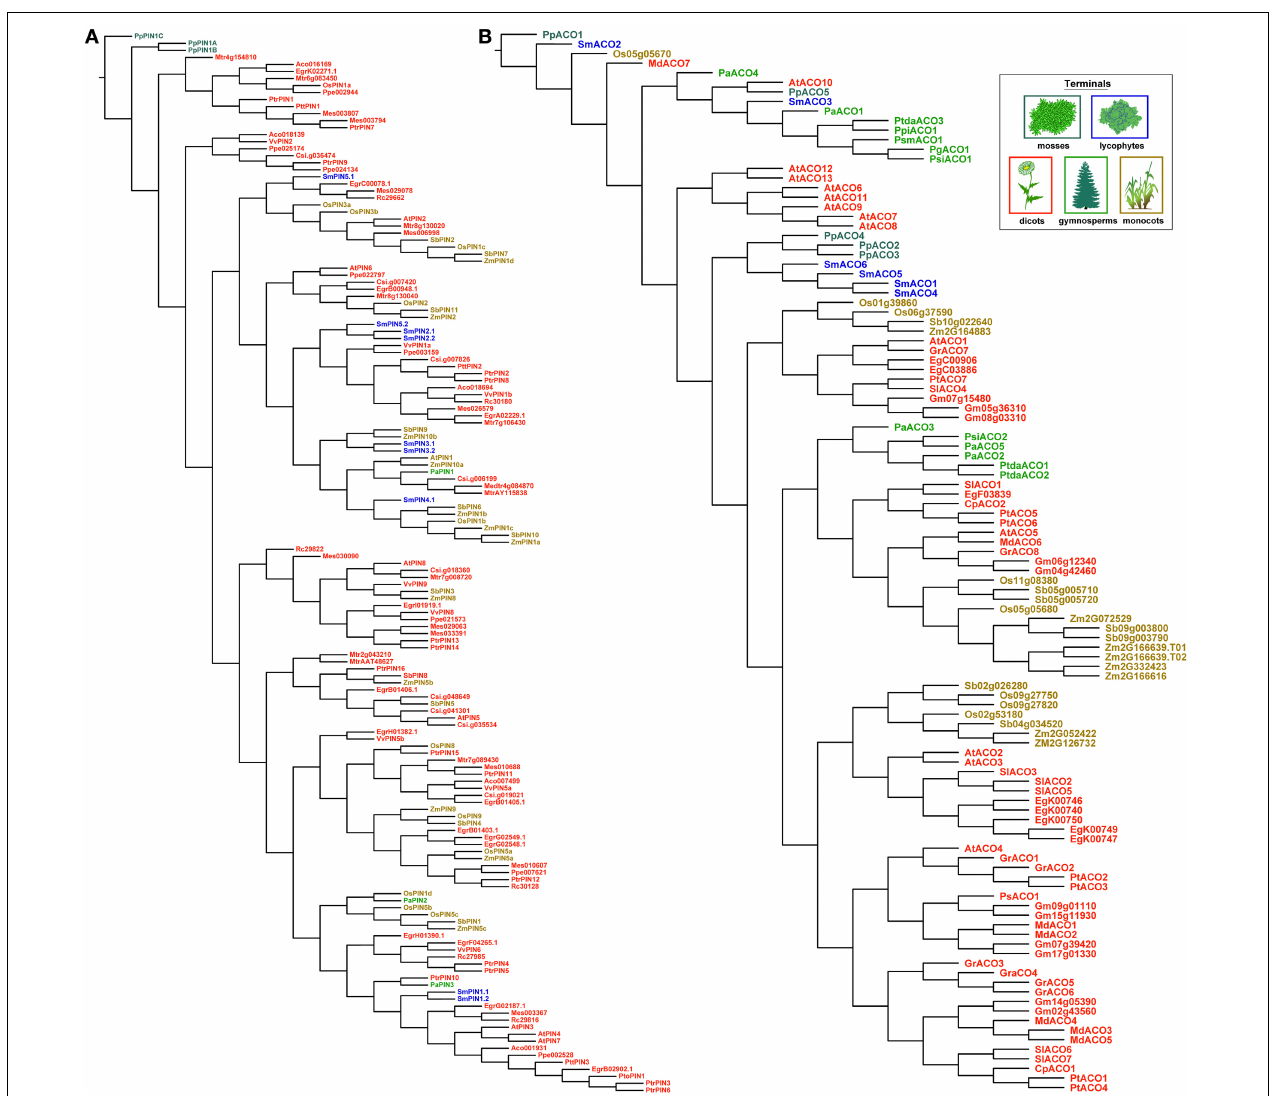
FIGURE 7 | The most parsimonious reconstructions of the PIN (A) and ACO (B) gene family histories, using amino acid sequences analyzed using dynamic homology (alignment and tree-search optimized simultaneously). Terminals are colored according to plant